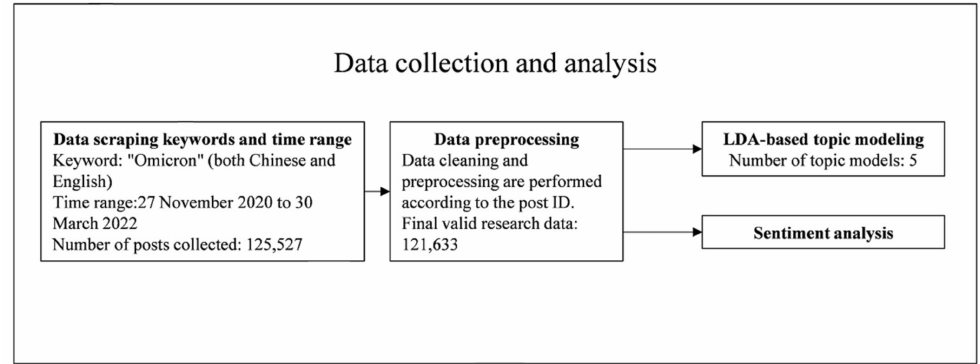
Figure 1. The research